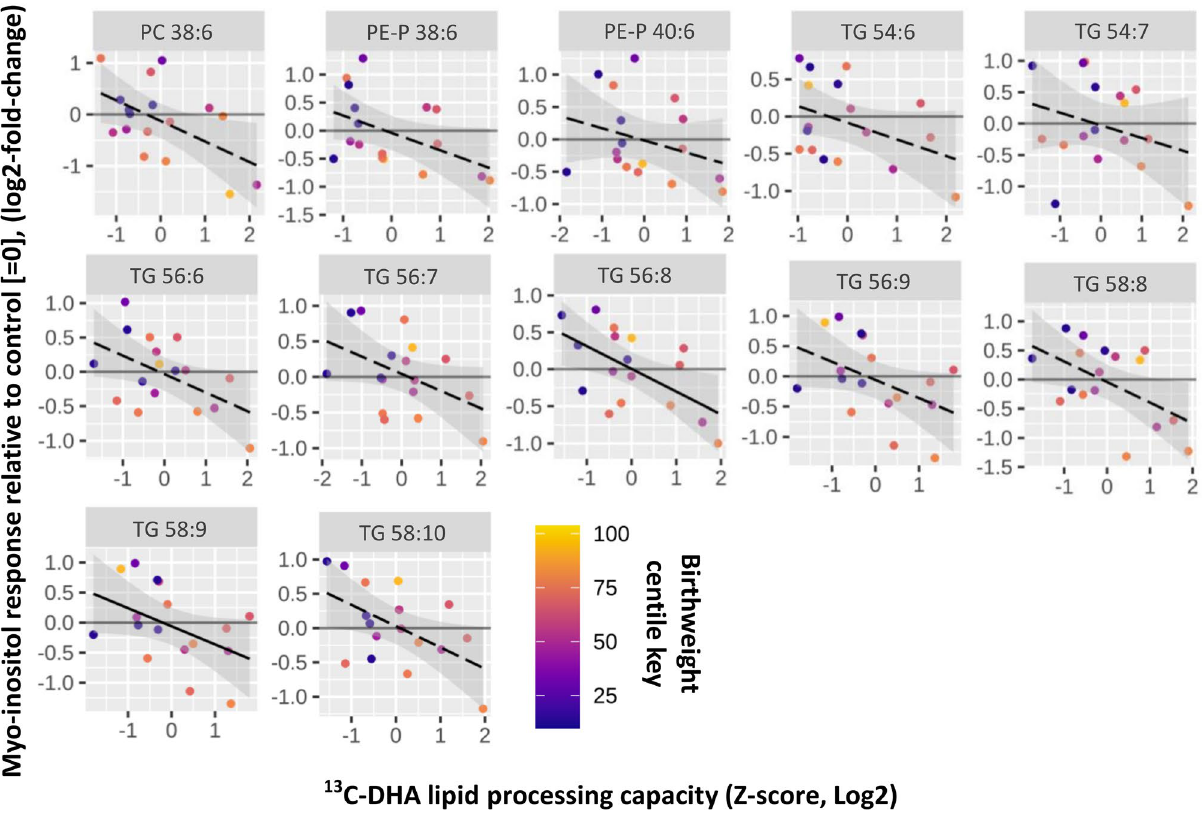
Figure 3. The association of basal lipid processing capacity in control explants (no additional myo-inositol) with myo-inositol response. Myo-inositol response represents the relative amount of 13 C-DHA lipid in placental explants treated with myo-inositol (60 µmol/L) compared with control explants from the same placenta not treated with myo-inositol. Linear regression was run with myo-inositol response (log2-fold-change) as the outcome and basal lipid processing (calculated by the formula ( 13 C-DHA/ ( 13 C-DHA + 12 C-DHA)) Z-score, log2 transformed) as the predictor variable. The Benjamini-Hochberg (BH) method was used to correct for multiple testing. Solid lines show statistically significant associations while dashed lines show non-significant trends. Shaded areas show 95% confidence intervals. Colors indicate birthweight